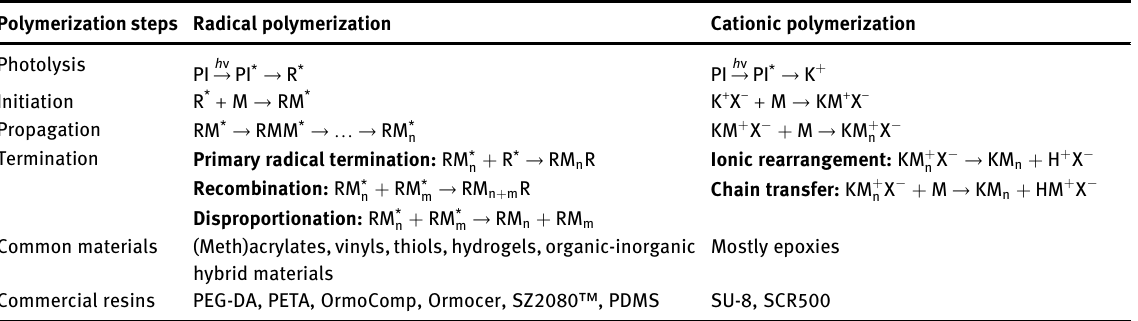
Table  : Equations of radical and cationic polymerizations, used common materials and available commercial resins. Polymerization steps Radical polymerization Cationic